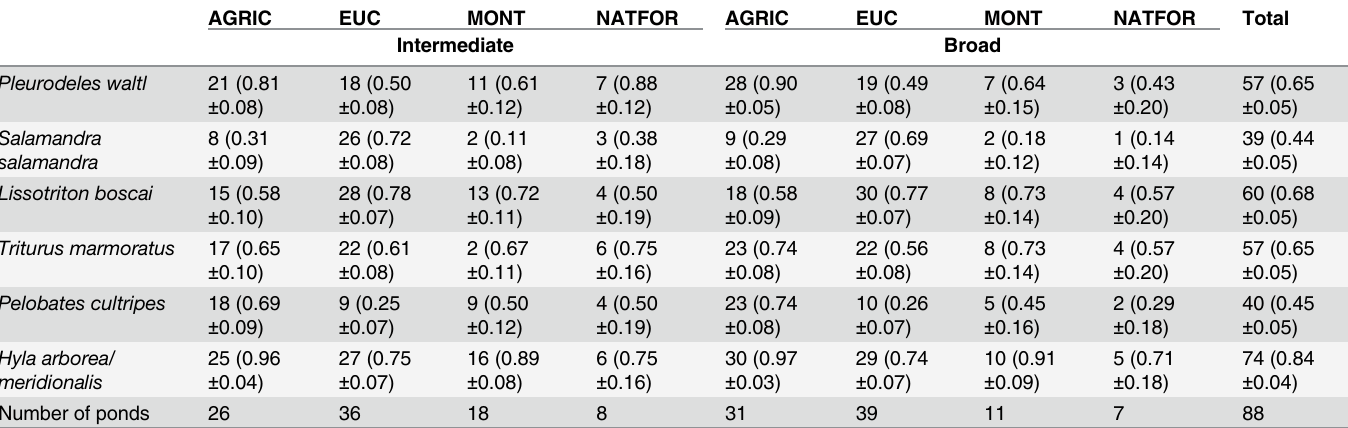
Table 1. Species